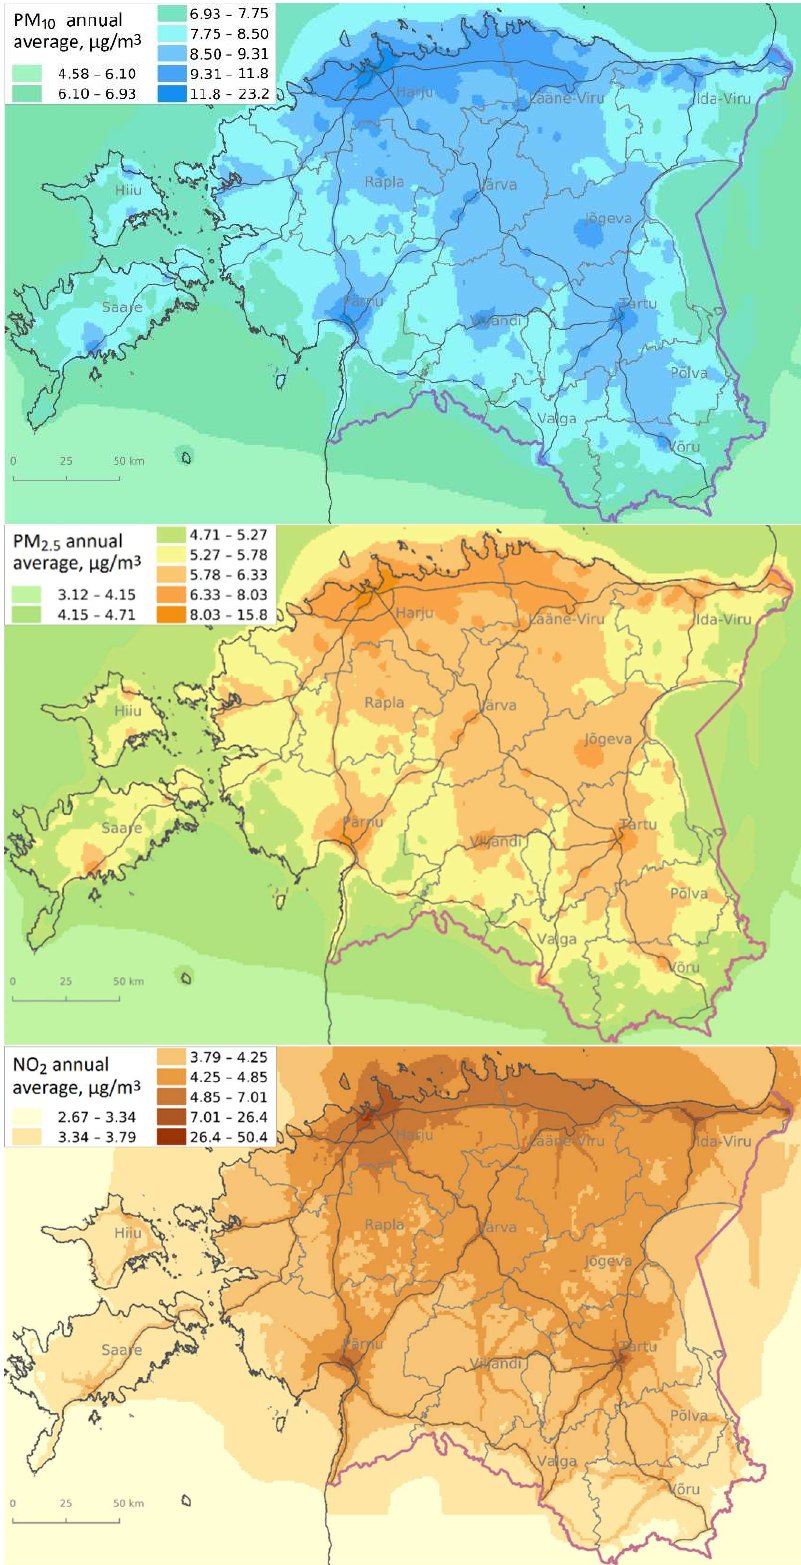
Figure 4. Modeled annual average concentrations of particulate matter (PM 10 ), fine particles (PM 2 . 5 ), and nitrogen dioxide (NO 2 ) in Estonia. Basemap: © Maaamet. The annual average concentrations of PM 10 , PM 2 . 5 , and NO 2 in four air quality moni- toring stations show a decreasing trend in 2004–2017; however, the concentrations